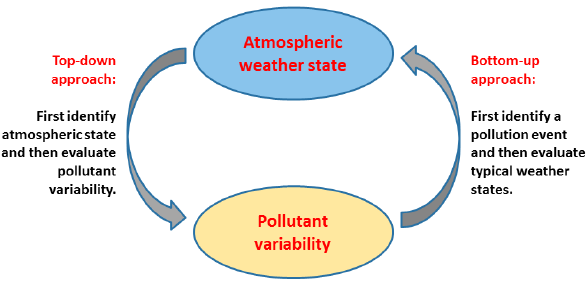
Figure 1. Schematic showing two different approaches to study sta- tistical co-variability of atmospheric weather states and pollutant concentrations.